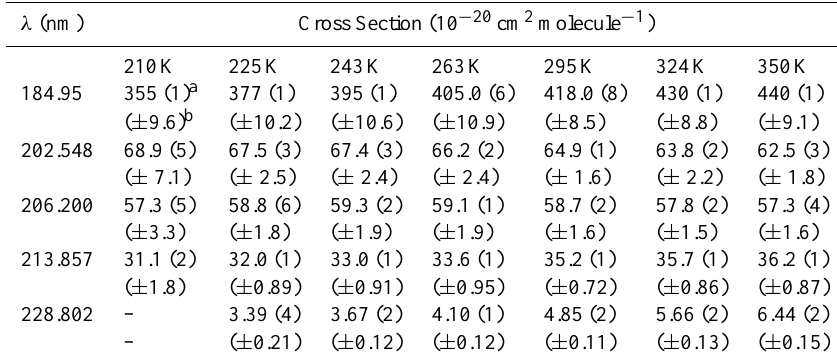
Table 2. UV absorption cross sections for CCl 4 obtained in this